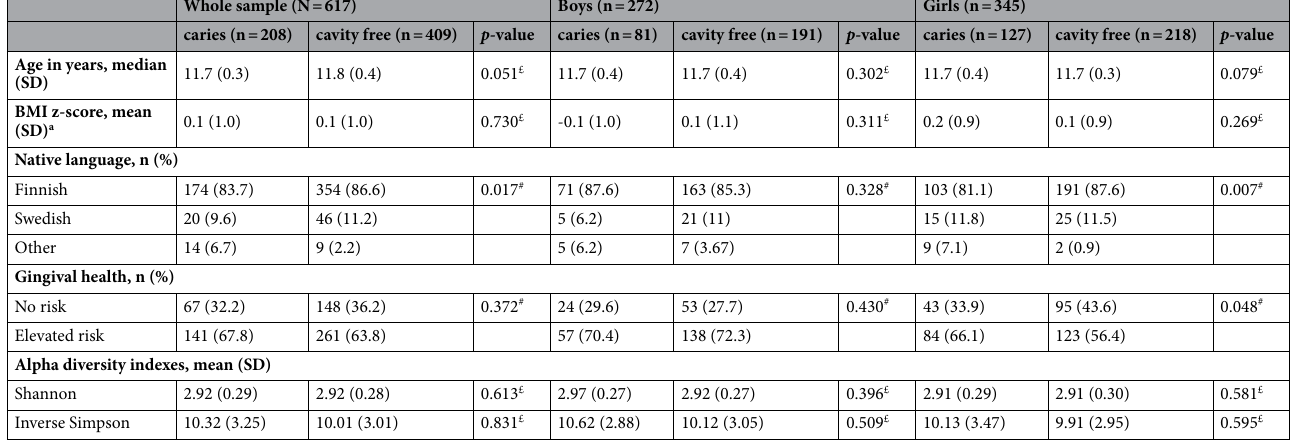
Table 1. Comparisons performed between caries and cavity free groups for whole sample and separately for boys and girls. # Fisher’s exact test, £ Independent samples t-test. a Data available for n = 603. BMI = body mass index, SD = standard